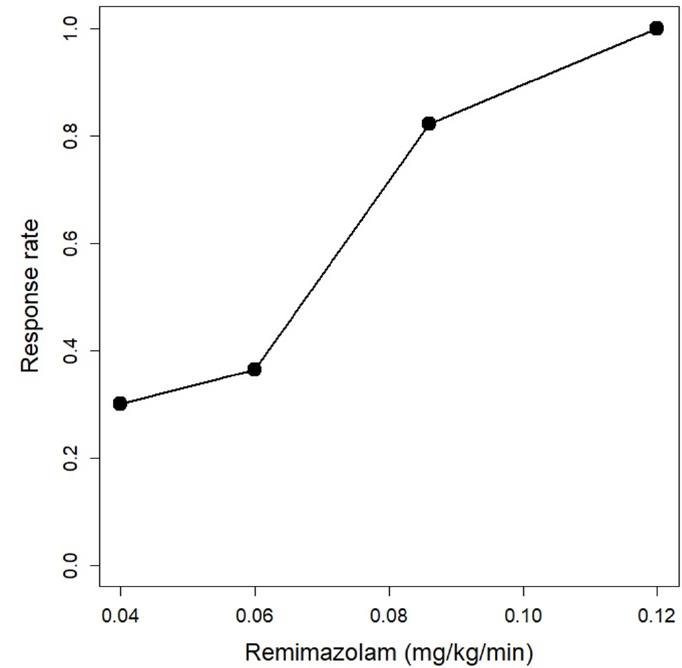
Figure 2. Centered pooled adjacent violators algorithm (PAVA) response rate. It predicted that an infusion rate of 0.10 mg/kg/min could induce loss of responsiveness within two minutes from the start of infusion in 90% of patients.